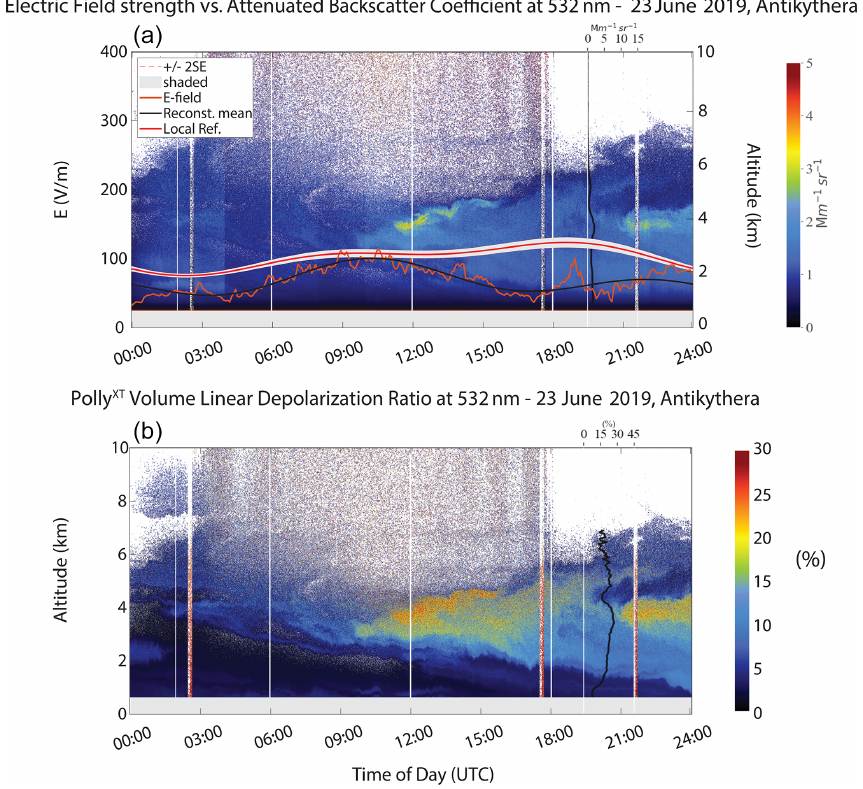
Figure 9. (a) Time series of the vertical electric field strength (orange), the extracted localized reference (ref.) electric field (red) and the reconstructed (reconstr.) mean electric field variation (black) from the field mill dataset, for the recorded 23 June 2019 dust layer at Antikythera. The E-field data are plotted with the time–height evolution of the attenuated backscatter coefficient (Mm − 1 sr − 1 ) and the particle backscatter coefficient ( β ) profile (Mm − 1 sr − 1 , black vertical line) at 532nm from the Polly XT lidar, which was co-located with the field mill. Areas of increased particle concentration are denoted with reddish tones, while the β values are derived by averaging between 18:00 and 21:00UTC. (b) Volume linear depolarization ratio ( δ v , %) at 532nm for the same dust layer as obtained from the Polly XT lidar and the particle linear depolarization ratio ( δ p , %) profile (black vertical line), again averaged between 18:00 and 21:00UTC. Large δ v values are depicted with reddish